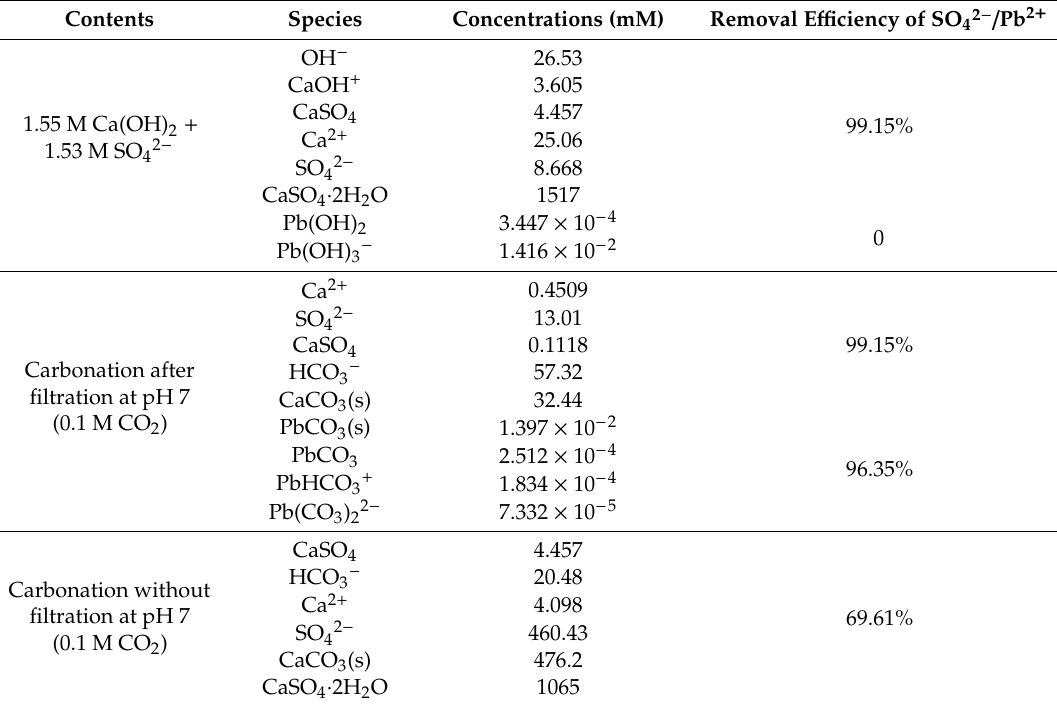
Table 3. Calculated equilibrium species distributions of the precipitation process and carbonation process, with and without filtration.